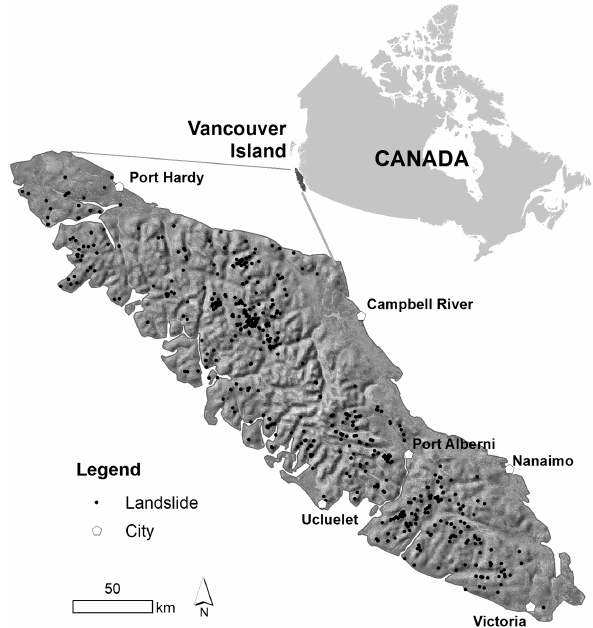
Figure 1. Vancouver Island and the locations of the landslides trig- gered from heavy rainfall in November